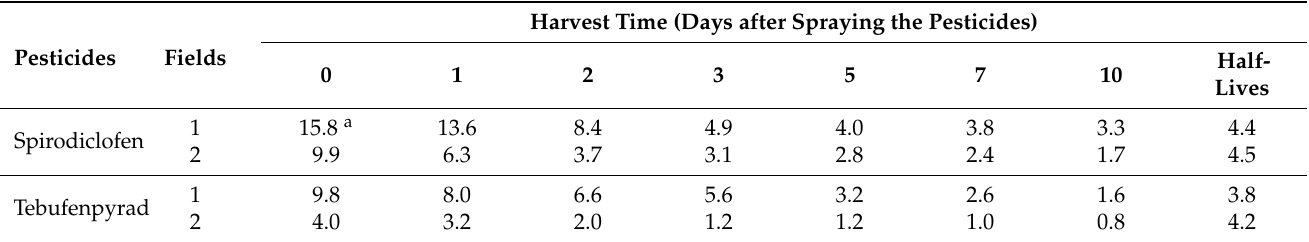
Table 3. Normalized values (NVs) a of spirodiclofen and tebufenpyrad in Aster scaber